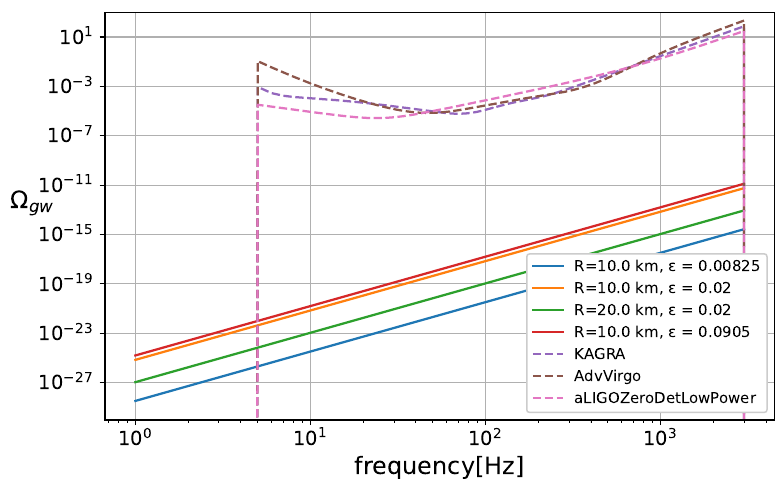
Figure 2. Ω gw ( f ) for different parametric preferences for the magnetar, produced SGWB high frequency model of the poloidal field configuration. The free parameters are (cid:101) and R , respectively. Furthermore, R is in km, as shown in the figure.